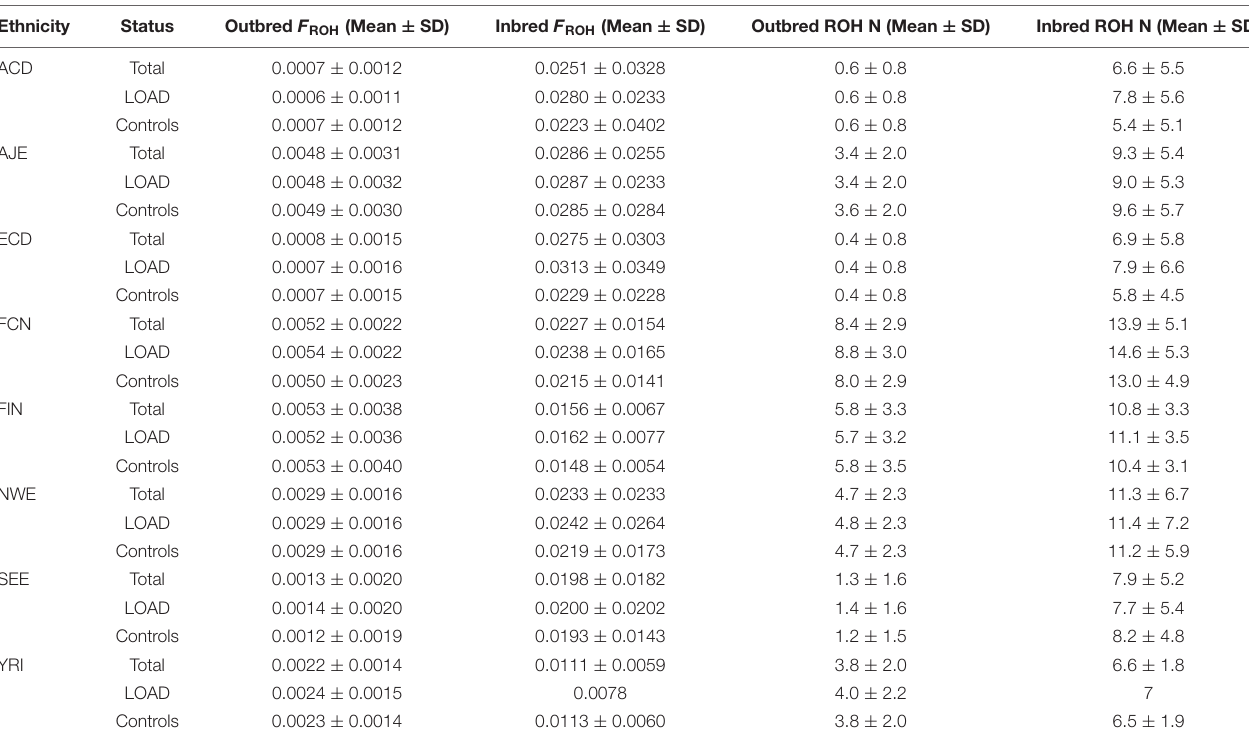
TABLE 2 | Genome-wide autozygosity determined through F ROH estimates and number of ROHs across the eight ethnic groups according to case-control and consanguinity status.